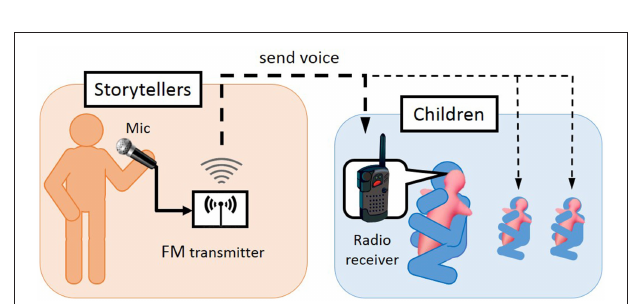
FIGURE 2 | Storytelling system with